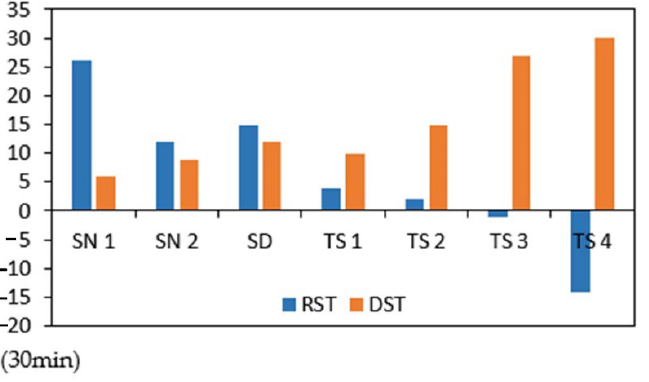
Figure 6. Response time and disruption time under severe weather